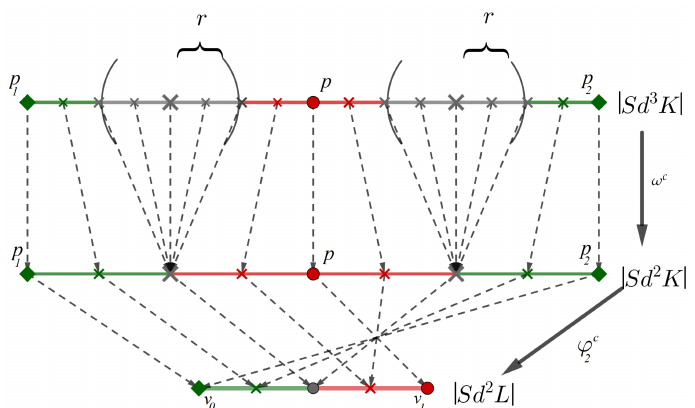
Figure 6. Three simplicial complexes with simplicial maps ω c and ϕ c illustrating a neural network N ϕ